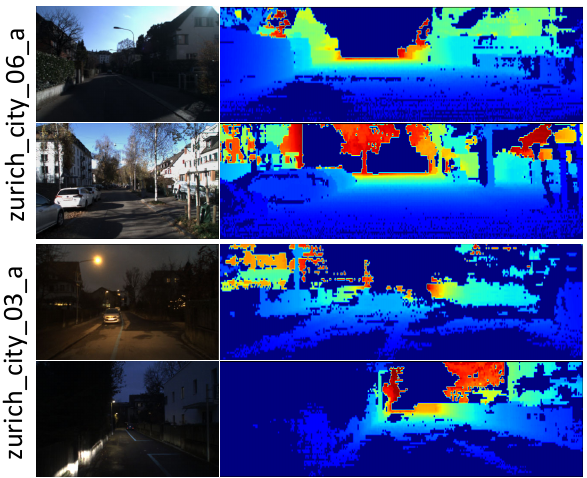
Figure 7. Typical samples in the test sequences of